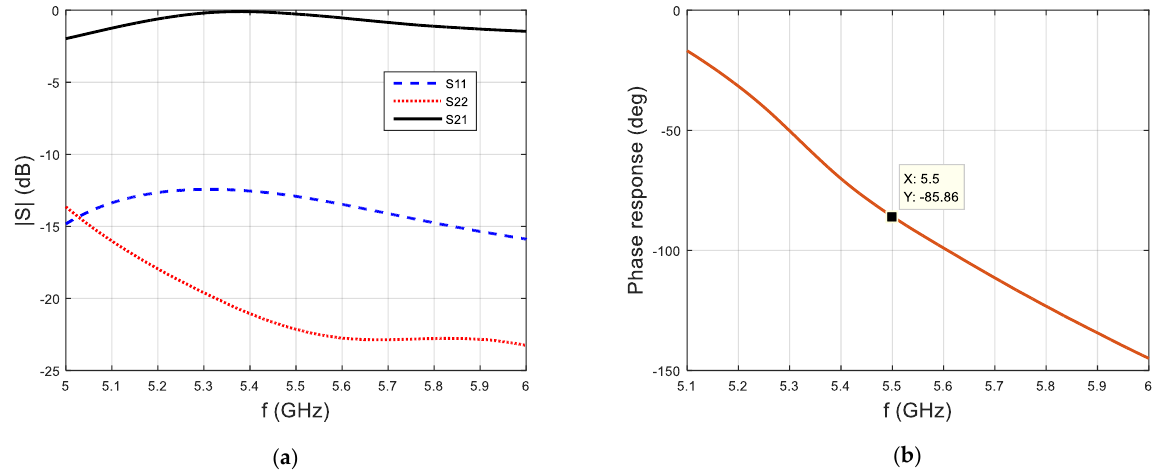
Figure 14. Measured results of a unit cell P-CRLH phase shifter. ( a ) Reflection coefficients, insertion loss. ( b ) Phase response.